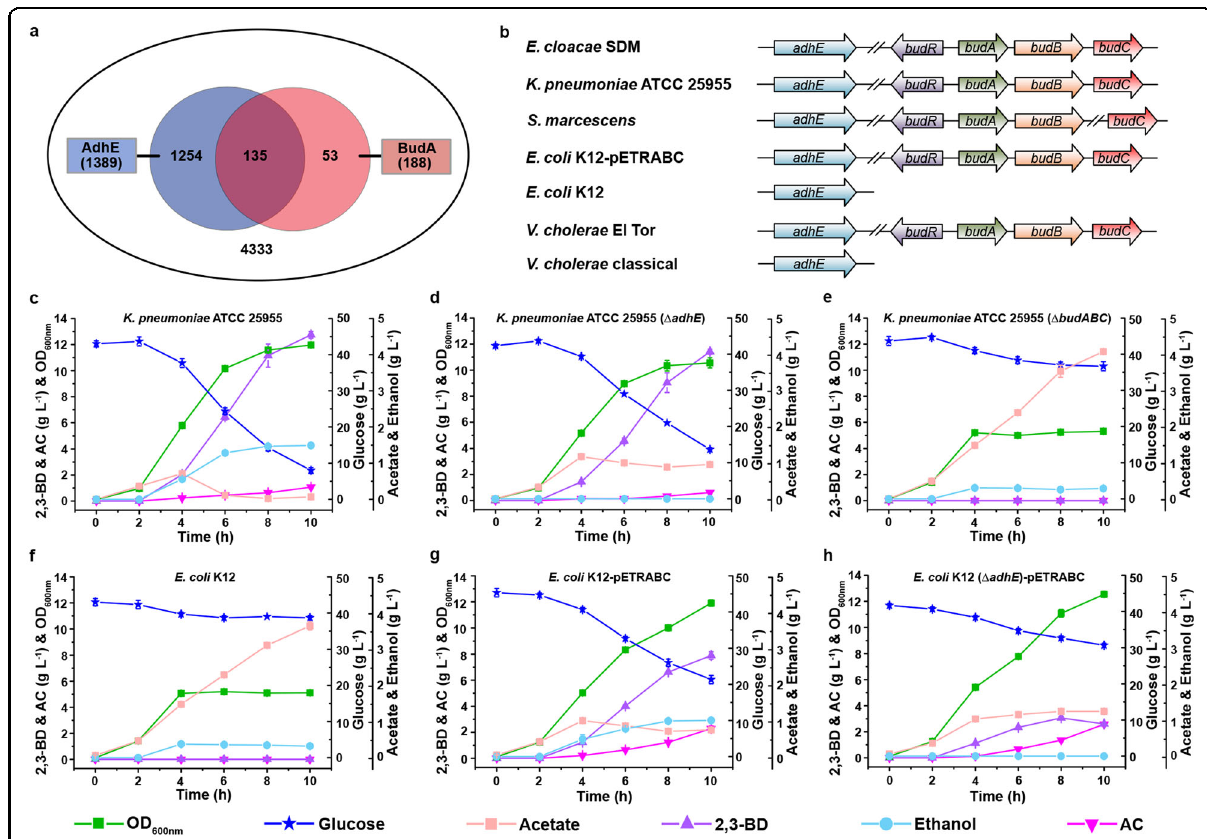
Fig. 3 Distribution and function of BudA and AdhE in bacteria. a The Venn diagram illustrates the occurrence and overlap of BudA and AdhE through genome context analysis. A total number of 4333 genomes were obtained by NCBI Blast online with the restriction of maximum identity level higher than 50%, query coverage of more than 90%, and E value lower than e − 30 . b Organizations of 2,3-BD biosynthesis operon and adhE gene in different bacteria. c Growth of K. pneumoniae ATCC 25955 using glucose as carbon source. d Growth of K. pneumoniae ATCC 25955 ( Δ adhE ) using glucose as carbon source. e Growth of K. pneumoniae ATCC 25955 ( Δ budABC ) using glucose as carbon source. f Growth of E. coli K12 using glucose as carbon source. g Growth of E. coli K12-pETRABC using glucose as carbon source. h Growth of E. coli K12 ( Δ adhE )-pETRABC using glucose as